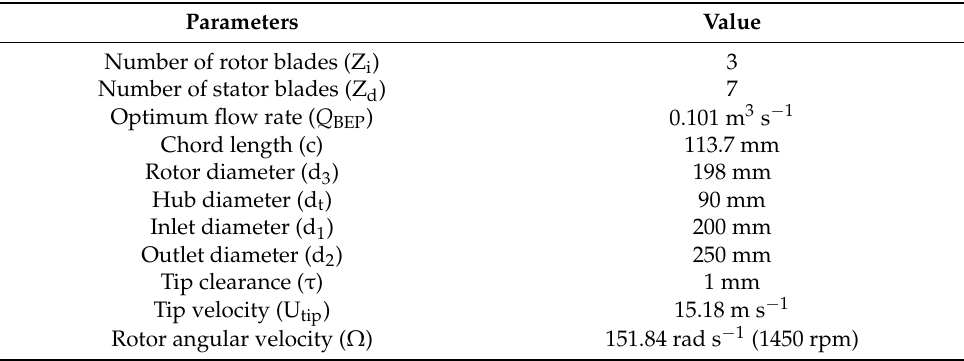
Table 1. Pump geometry and reference data.